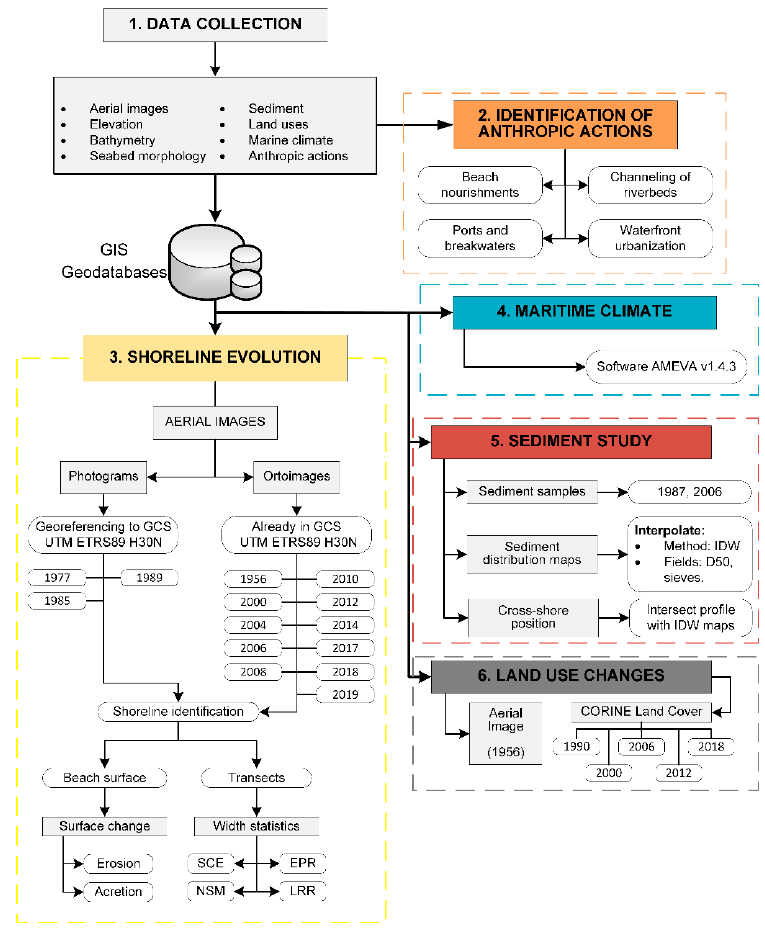
Figure 2. Scheme of the methodology followed.